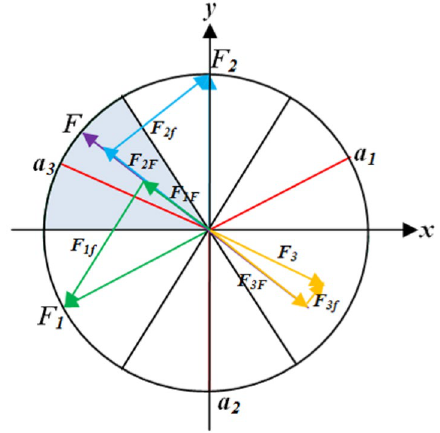
Fig. 16 Output of the pad forces controlled using the present algo- ’ ≤ 270 rithm for given different α K